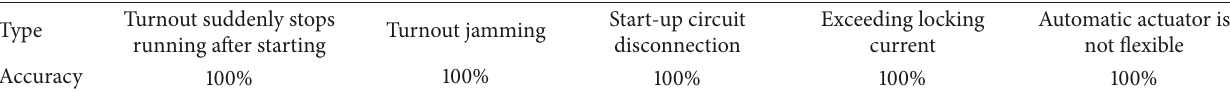
Table 3: Accuracy of fault